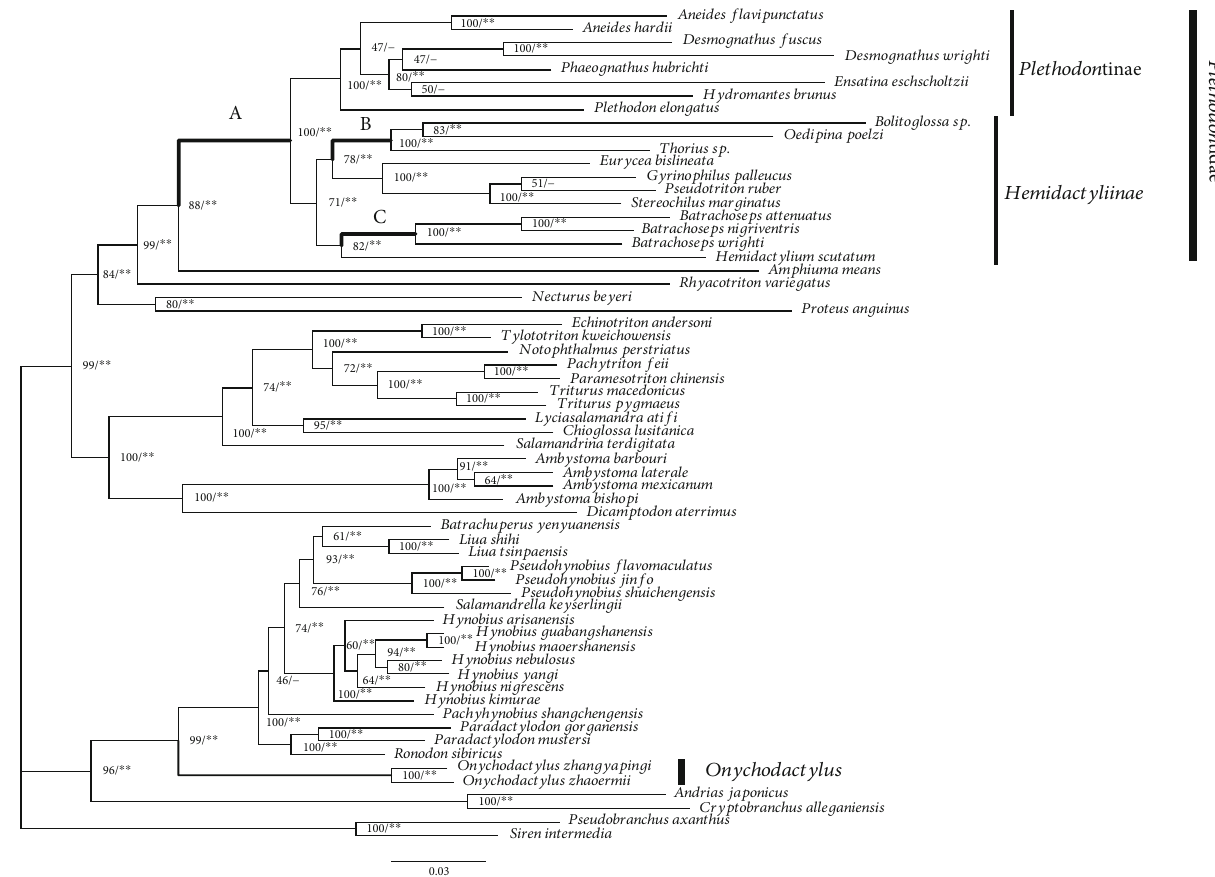
Figure 1: Caudate phylogeny inferred from 13 mitochondrial protein-coding genes (6,888bp). The ML tree is shown. Bootstrap support and Bayesian posterior probability ( ∗∗ > 0 : 99 , ∗ >0 : 95 ) are denoted on each node. Species names in bold indicate direct-developing species. Branches with gray show lineages of lunged salamanders. Branches A, B, and C indicate the plethodontid branches with positively selected codon sites detected by